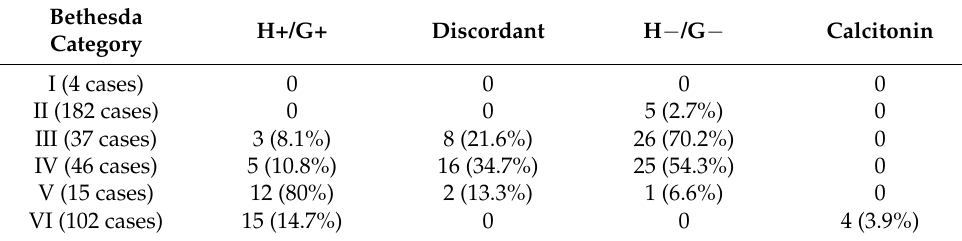
Table 8. ICC evaluation performed on 122 control cases out of 386.